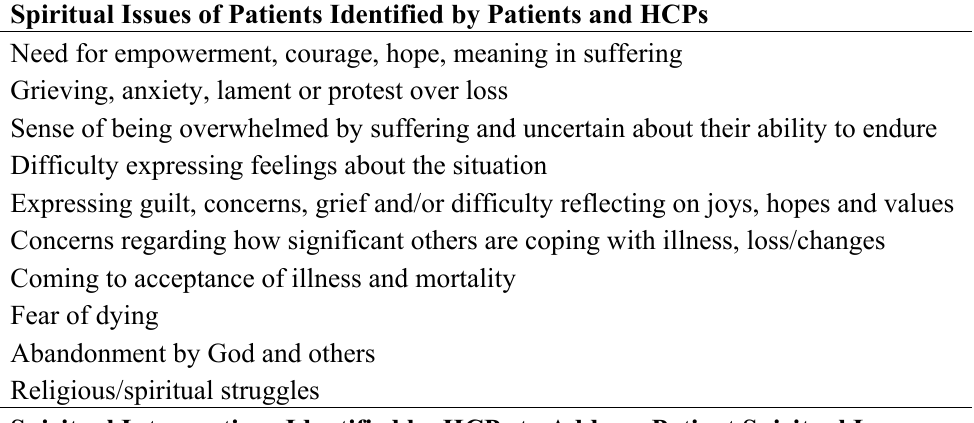
Table 4. Spiritual issues and